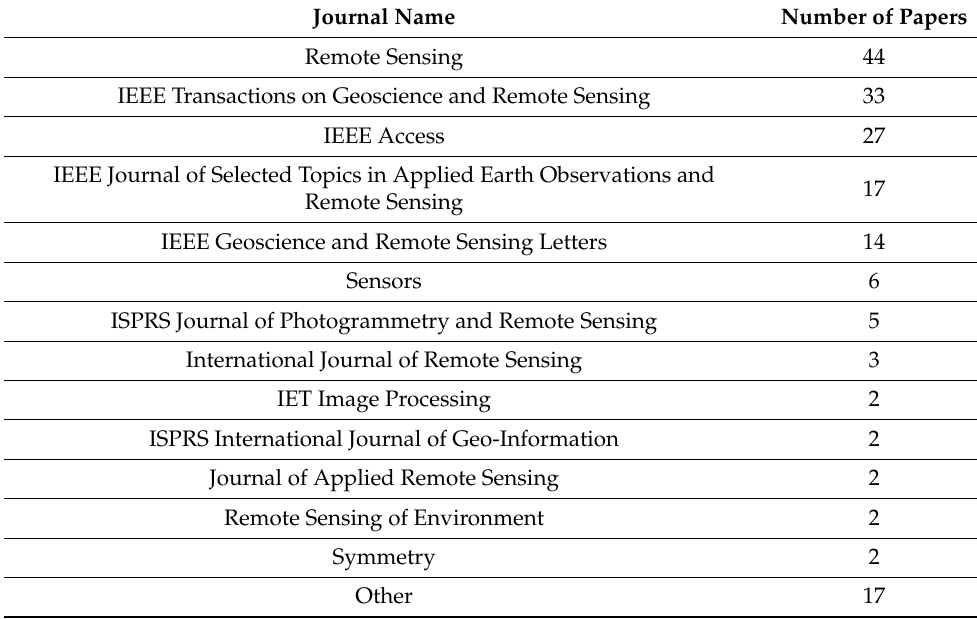
Table 2. Journal names and their corresponding number of papers in attention mechanism-based DL for